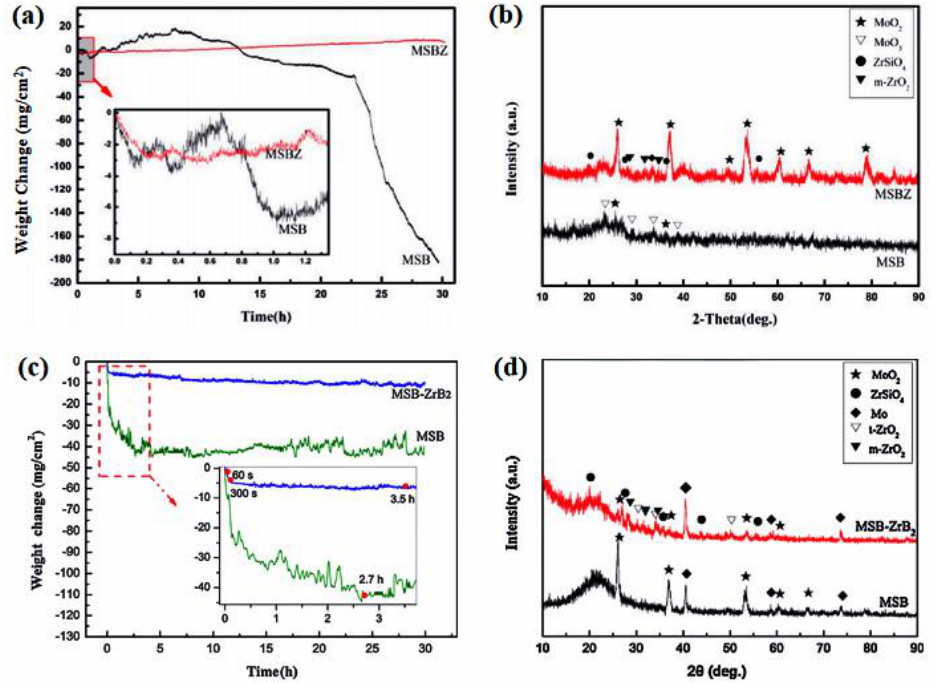
Figure 9. The different alloys after oxidation 30 h at ( a , b ) 900 °C and ( c , d ) 1300 °C: ( a , c ) mass change curve, ( b , d ) XRD analysis results. ( a – d ) reproduced with permission [53,54], respectively. Copyright 2017